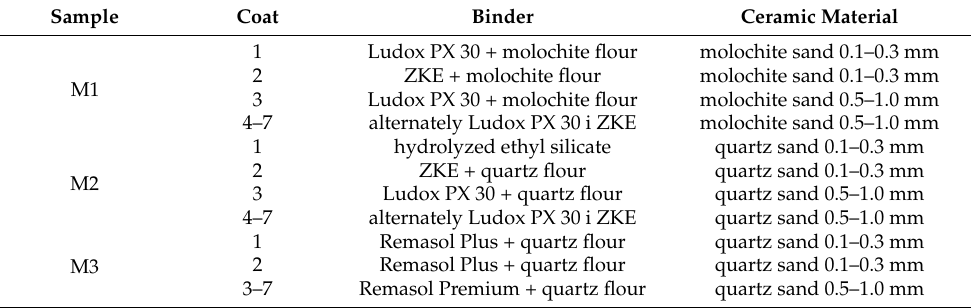
Table 1. Materials composition of the ceramic samples.